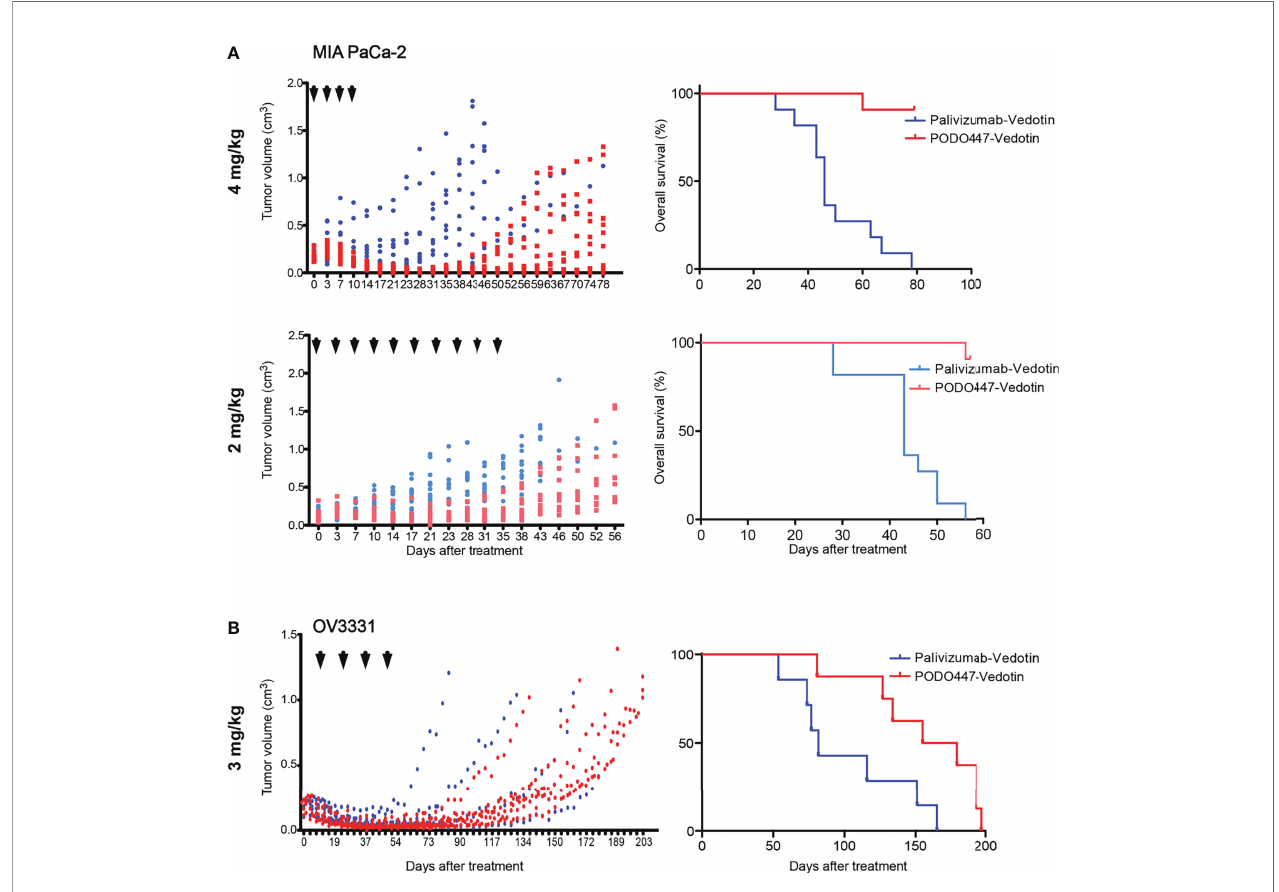
FIGURE 5 | Therapeutic effect of PODO447 on pancreatic and ovarian tumor-bearing NSG mice. Assessment of PODO447- (blue) and palivizumab-ADC (red) in vivo therapeutic effect. Once cancer cells injected subcutaneously into the fl ank of NSG mice became palpable (approximately 0.1 cm 3 ) mice were injected with ADCs. Graphs show therapeutic effect on tumor growth (left panel) and overall survival (right panel). (A) MIA PaCa-2 tumors treated at 4mg/kg/injection (left P < 0.001; right P < 0.0001) and 2mg/kg/injection (left P < 0.001; right P < 0.0001), (B) OV3331 patient-derived tumors treated at 3mg/kg/injection (left ns; right P < 0.05). ADCs were administered i.v. according to the treatment schedule indicated by the arrowheads. Data in (A) is from two independent experiments with n = 5-6 mice per group. Data in (B) is from two independent experiments with n = 4-5 mice per